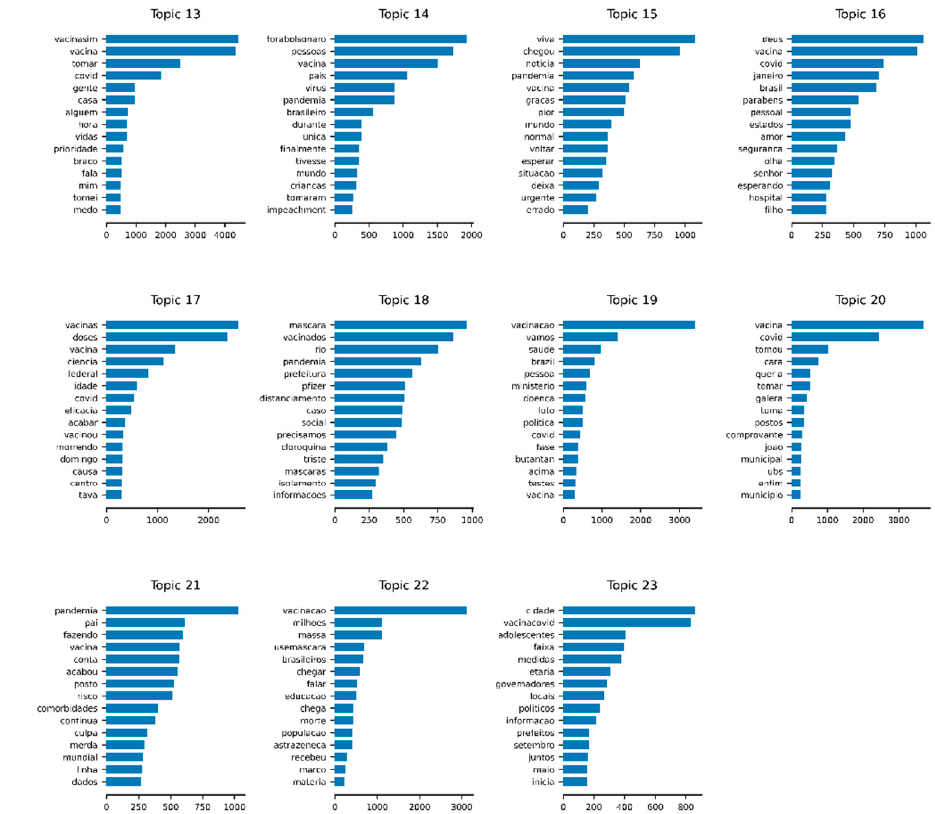
Figure 7. The fifteen terms with the highest weights in each topic. The segregation of clusters of tweets according to related topics was generated from the results of the t -SNE method, allowing another kind of visualization of the topics’ distributions in a two-dimensional projection. These clusters are shown in Figure 8.